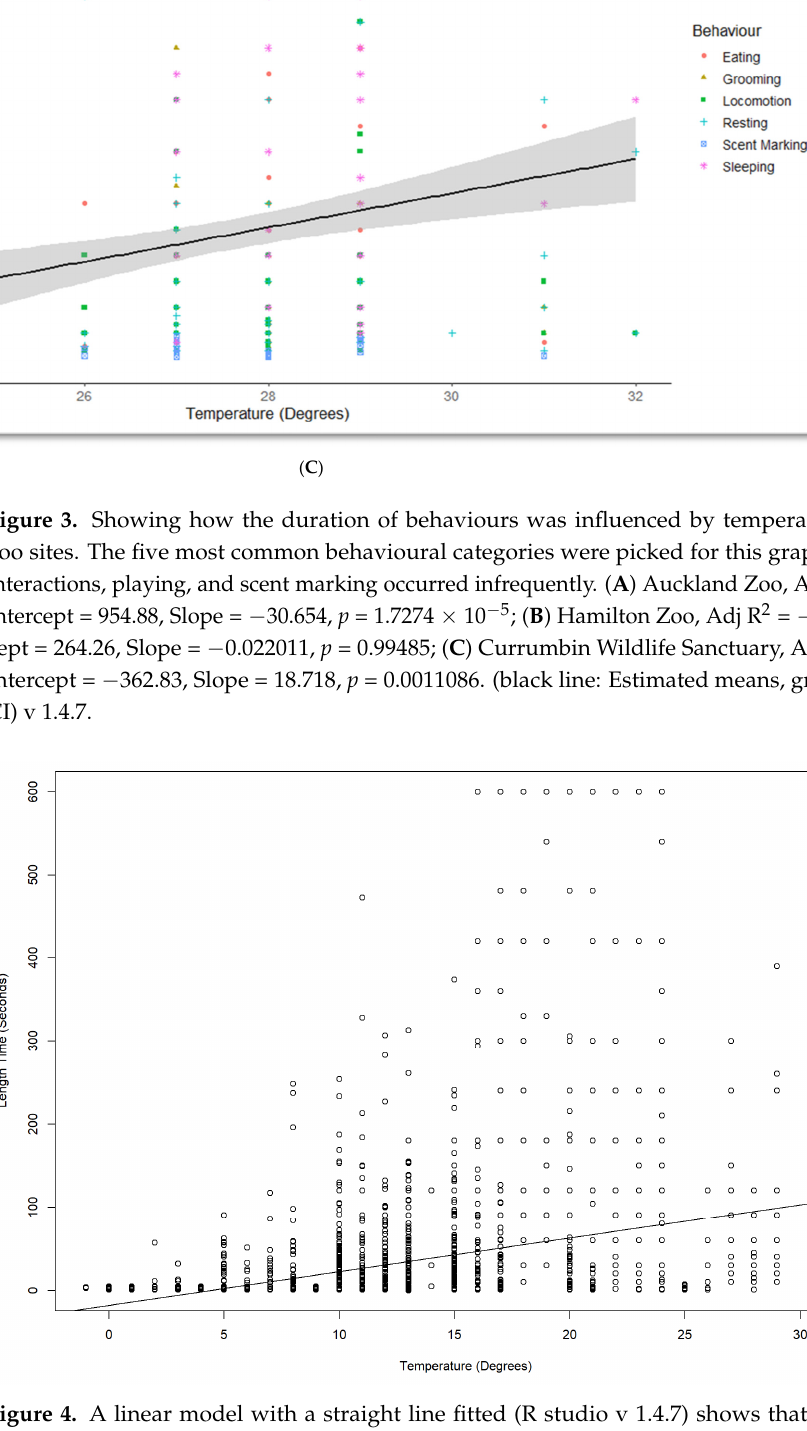
Figure 4. A linear model with a straight line fitted (R studio v 1.4.7) shows that the duration of locomotion events across all zoos was affected by temperature.